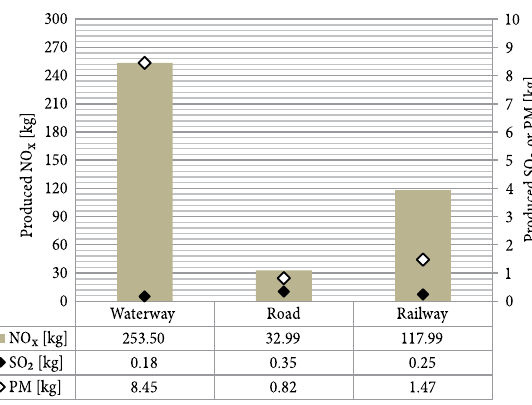
Fig. 7. Air pollutants per mode of transport